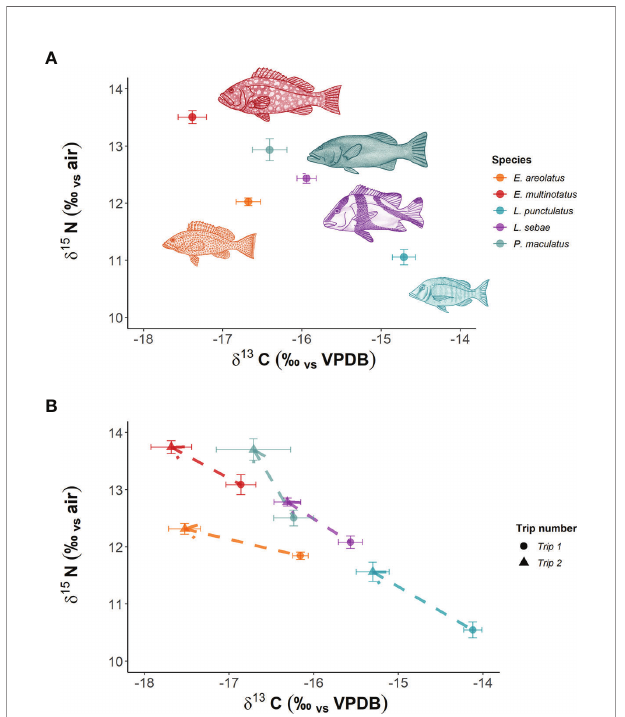
FIGURE 2 | Mean isotopic signatures of predatory fi sh species in NW Australia. Panel (A) shows overall mean values for both trips combined, while Panel (B) shows means per trip. Dashed lines with arrows indicate direction of trend between trips.